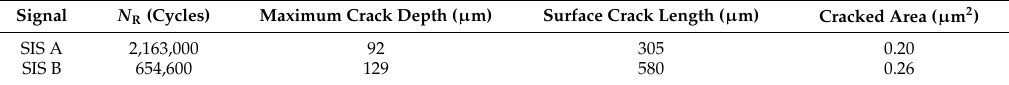
Figure 5. Fracture surfaces with details of the initiation area in test in air at Δε t /2 = 0.6% interrupted after 1350 cycles using the ( a ) SIS A signal and ( b ) SIS B signal.